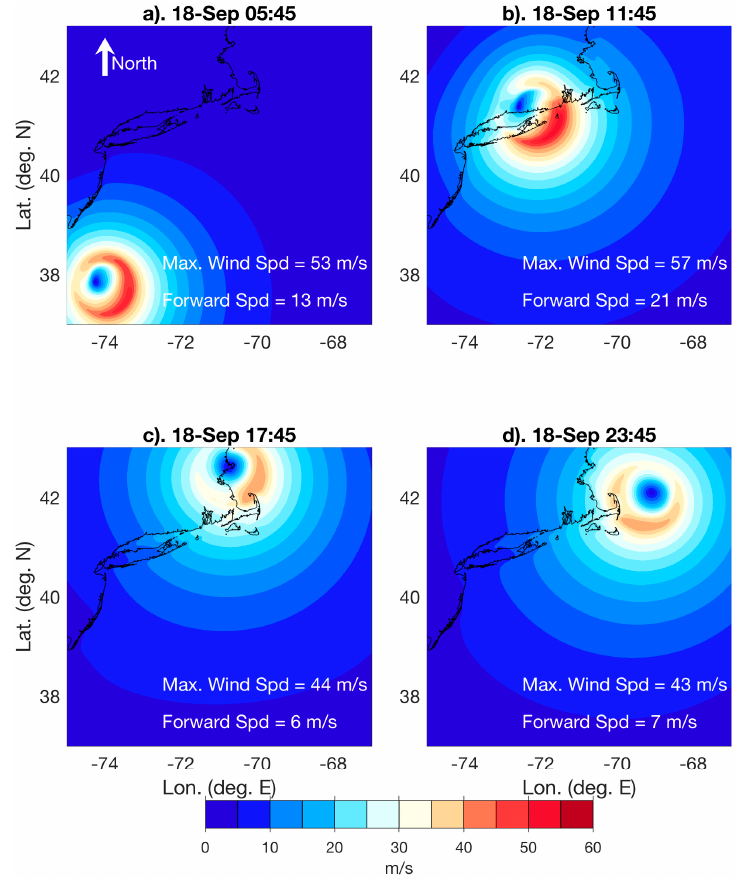
Figure 5. Wind speed at 10 m height for Hurricane Rhody at 6-h intervals during the period in